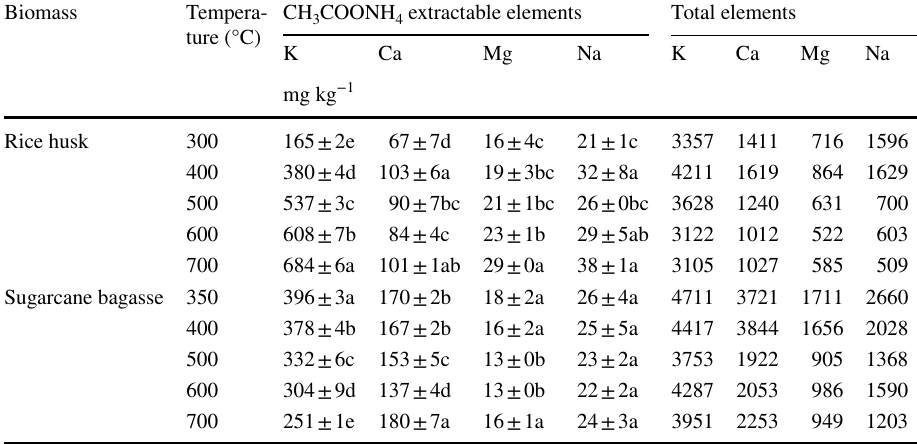
Values followed by the same letter within RHB or SBB columns were not significantly different at P < 0.05 according to Duncan’s Multiple Range Test. Values represent mean ± standard deviation of ( n